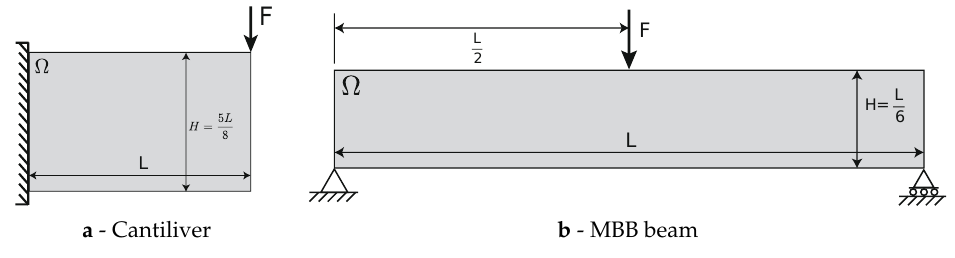
Figure 3. Benchmark problems’ definition